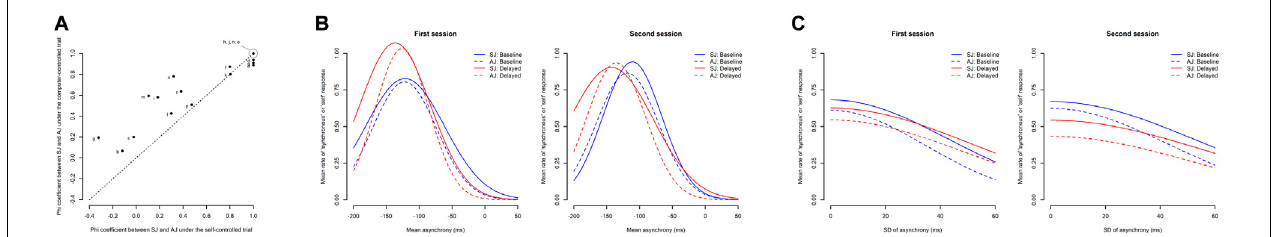
FIGURE 11 | Relationship between the simultaneity judgment (SJ) and the agency judgment (AJ) data. (A) Correlation between the SJ and AJ for each participant (phi coefficients). The x axis represents the phi coefficients under the self-controlled trials, while the y axis represents those under the computer-controlled trials. Each alphabetical letter indicates an individual participant. (B) Overlapped fitted Gaussian function of the SJ ( Figure 4B ) and AJ ( Figure 7B ) against the mean asynchrony. (C) Overlapped fitted half-Gaussian function of the SJ ( Figure 5B ) and AJ ( Figure 8B ) against the SD of asynchrony.